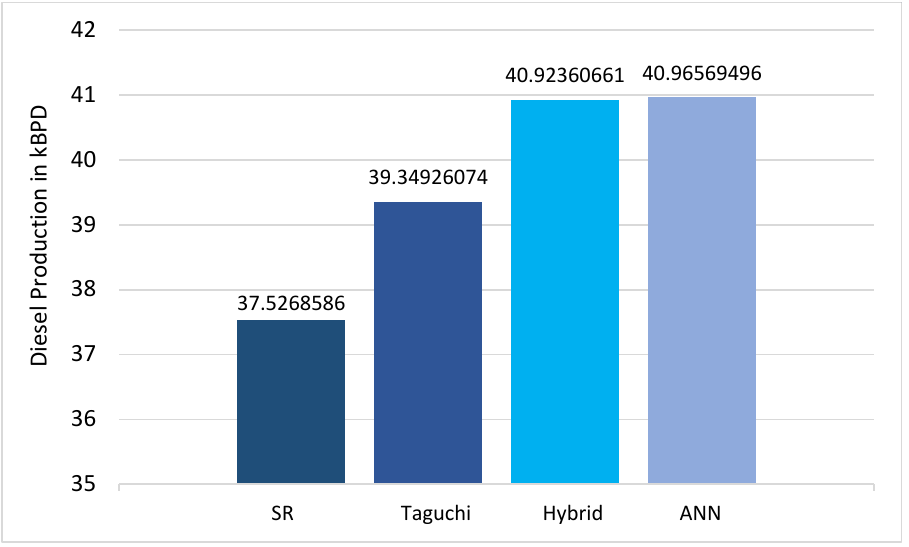
Figure 9. Average diesel production of 28 testing samples.